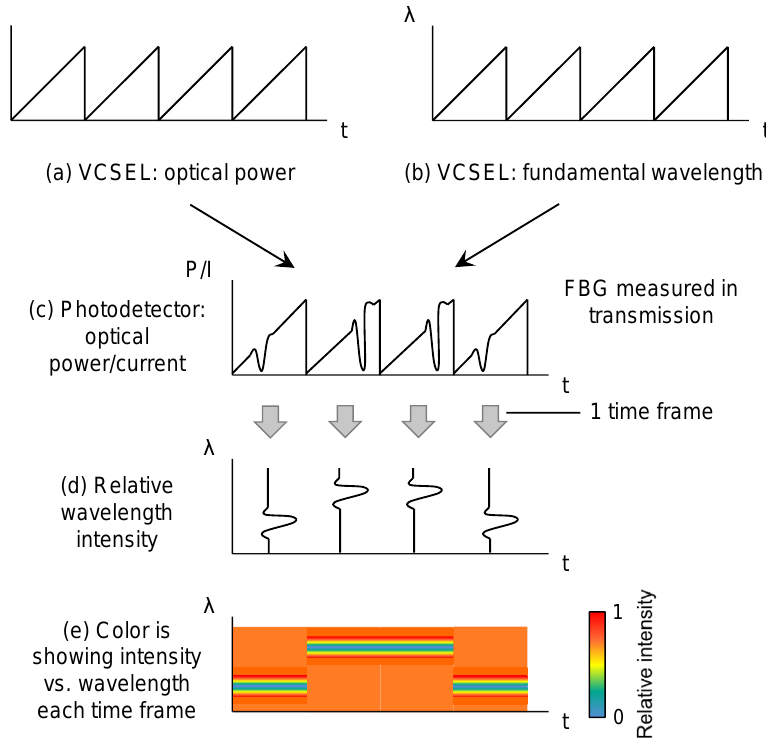
Figure 3. Schematic example of the fiber sensor interrogation principle (modulation mode)